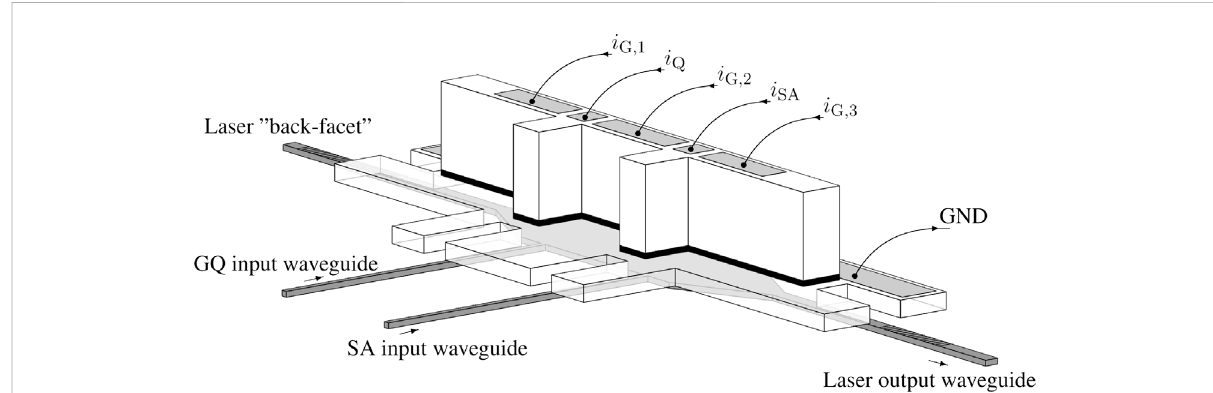
FIGURE 1 3D-Schematic view of the neuron laser: the IIIV material is processed on top of an silicon photonics wafer to allow coupling between the underlying silicon waveguides and the gain material. Biasing currents are injected into the top electrodes (InP + ) through the quantum wells (represented as a black layer) to the ground electrode (InP − ). Two waveguides perpendicular to the main laser cavity are used to feed optical power directly into the GQ and SA parts of the laser. The detailed structure of the laser can be inferred from [5, 6].